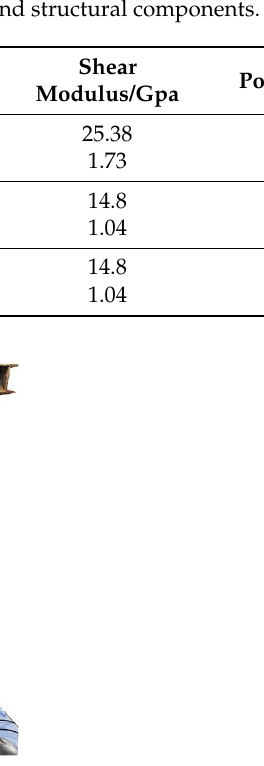
Figure 2. Model test system.